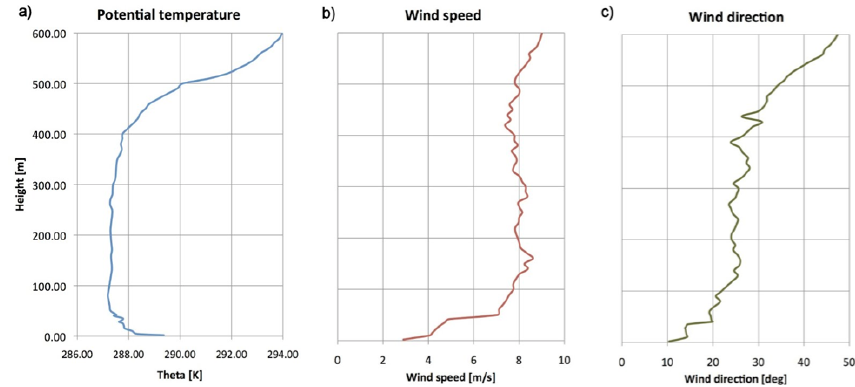
Fig. 3. Initial atmospheric profiles used for model initialization: (a) potential temperature, (b) wind speed, and (c) wind direction.